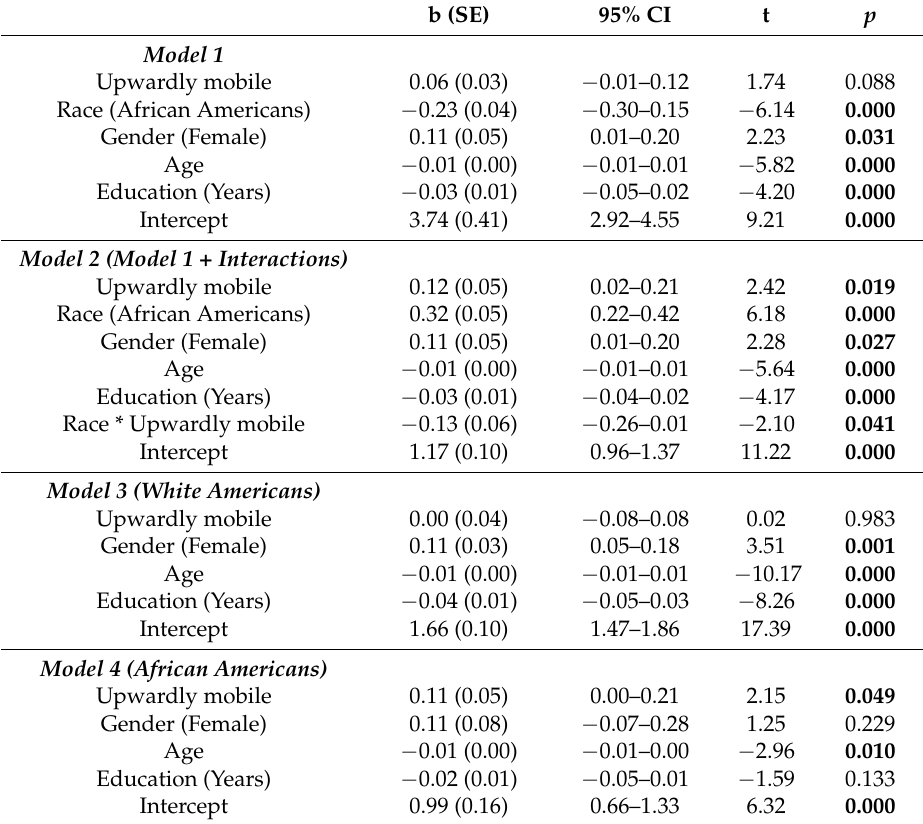
Table 2. Linear regressions between upward social mobility and